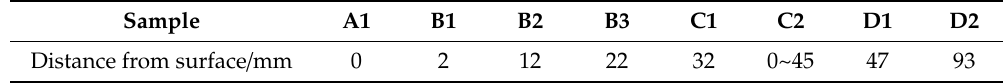
Figure 1. Schematic of sampling locations in casting slab. A is the chilled layer zone, B is columnar zone, C is columnar-to-equiaxed transition zone (CET zone), and D is equiaxed zone. ( a ) General view of the slab; ( b ) isometric view of slab; ( c ) top view of slab. Table 2. Sampling location of each zone in casting slab.